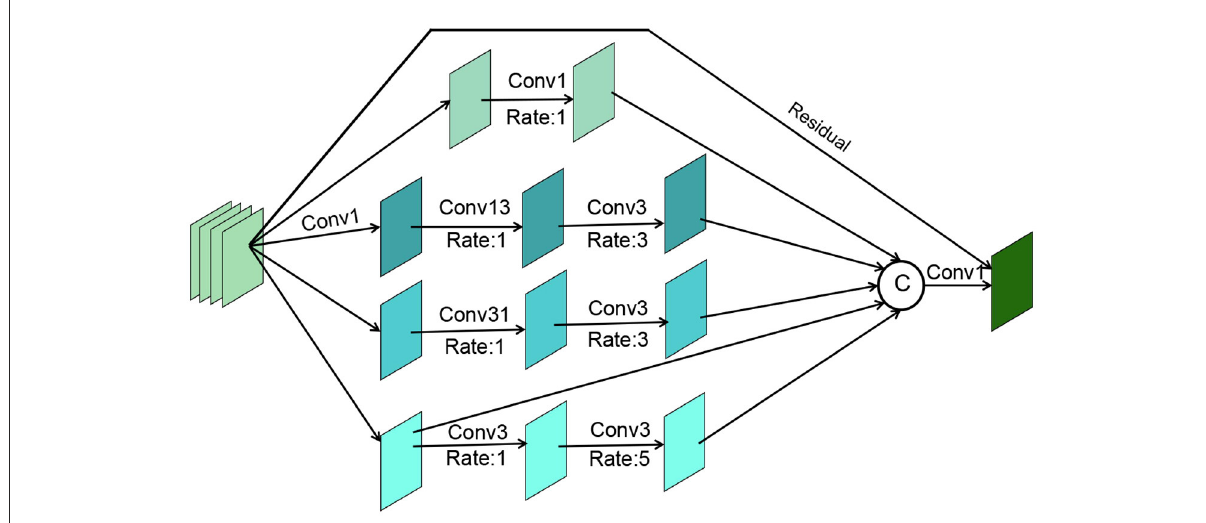
FIGURE5 The proposed Global Context-aware Block (GCB)